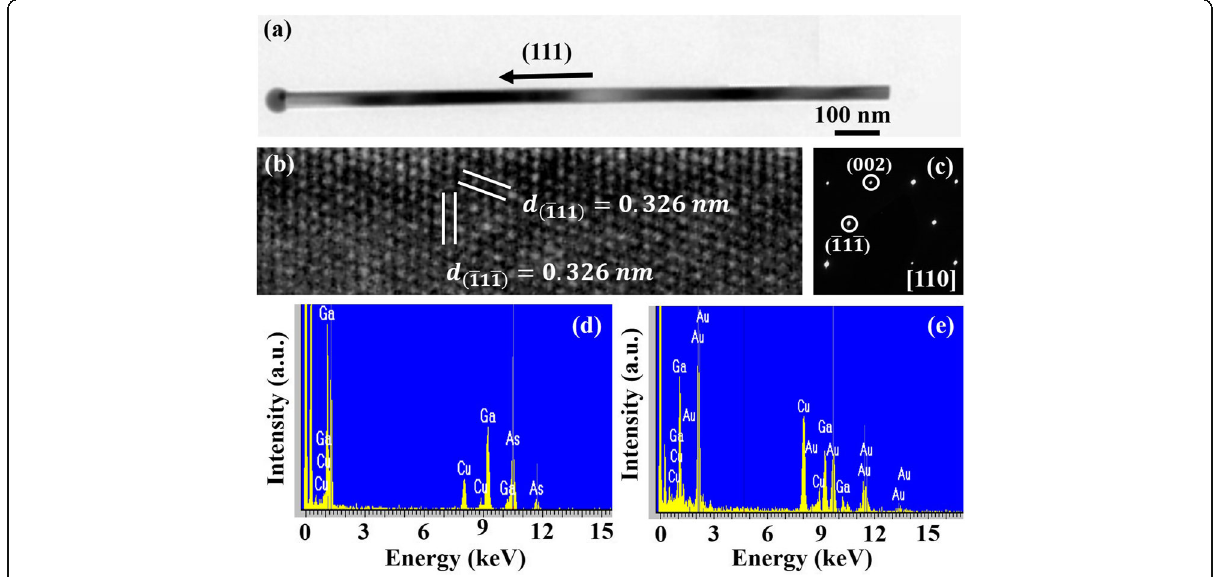
Fig. 2 TEM, HRTEM, SEAD, and EDS. a A TEM image of a representative Au-catalyzed GaAs nanowire. The corresponding high-resolution TEM (HRTEM) image and SAED pattern are shown in ( b ) and ( c ), respectively. d , e The EDS spectra of the corresponding NW that taken from top of AuGa x and stem,